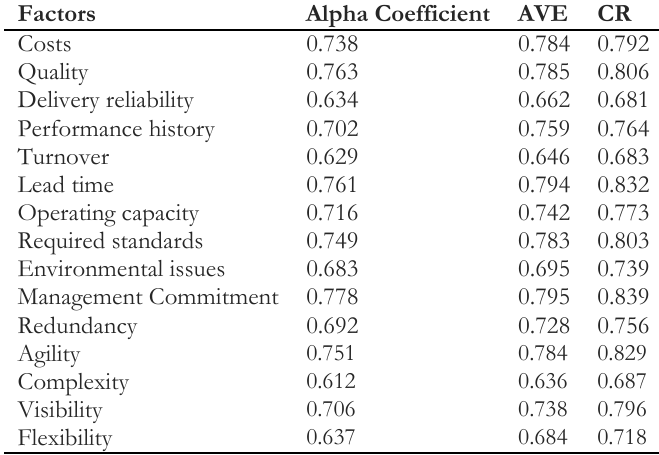
Table 3. The reliability and validity of the research factors.